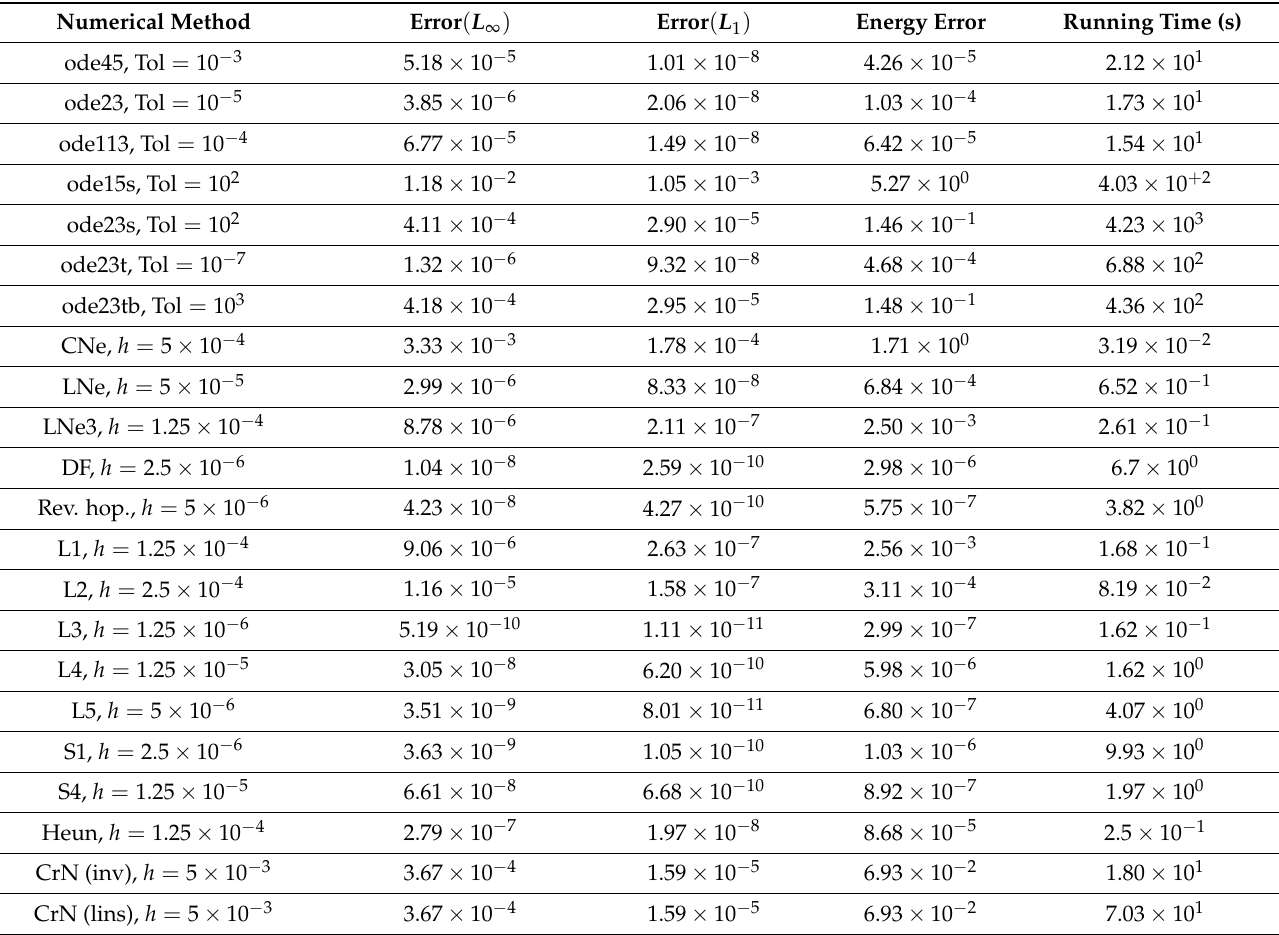
Table 1. Comparison of different leapfrog-hopscotch algorithms with other methods for the moderately stiff system of ten thousand